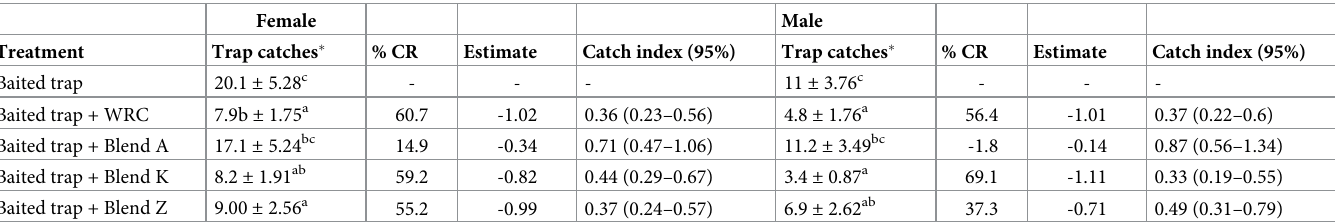
Table 3. Mean trap catches (SEM) and catch indices of G . pallidipes in cow urine and acetone-baited Ngu traps combined with different blends (n =